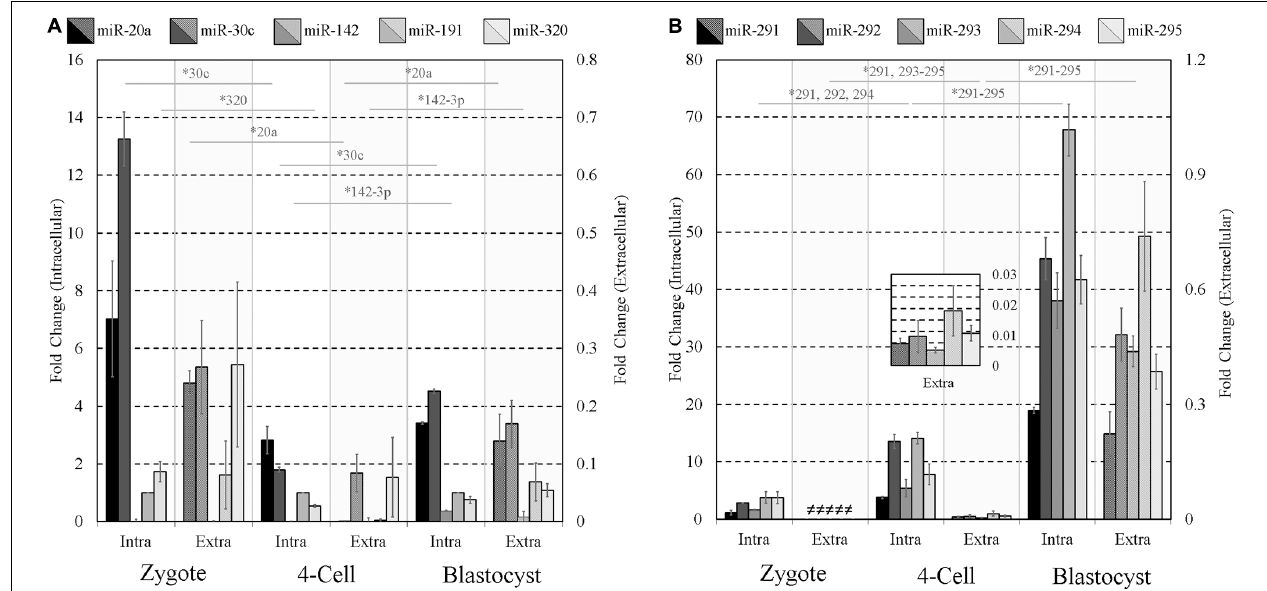
FIGURE 4 | Intracellular and extracellular miRNA profile comparison of zygote, 4-cell, and blastocyst embryos. The extracellular miRnome of staged embryos containing highly variable intracellular miRNA profiles was characterized using panels (A,B) sequences to evaluate the panel’s ability to resolve differences between embryos of different states. Each dataset has been normalized against endogenous intracellular miR-191. Blank media was cultured in tandem and used as a negative control. n = 3. Error bars = SEM. ∗ p < 0.05; only significant differences are